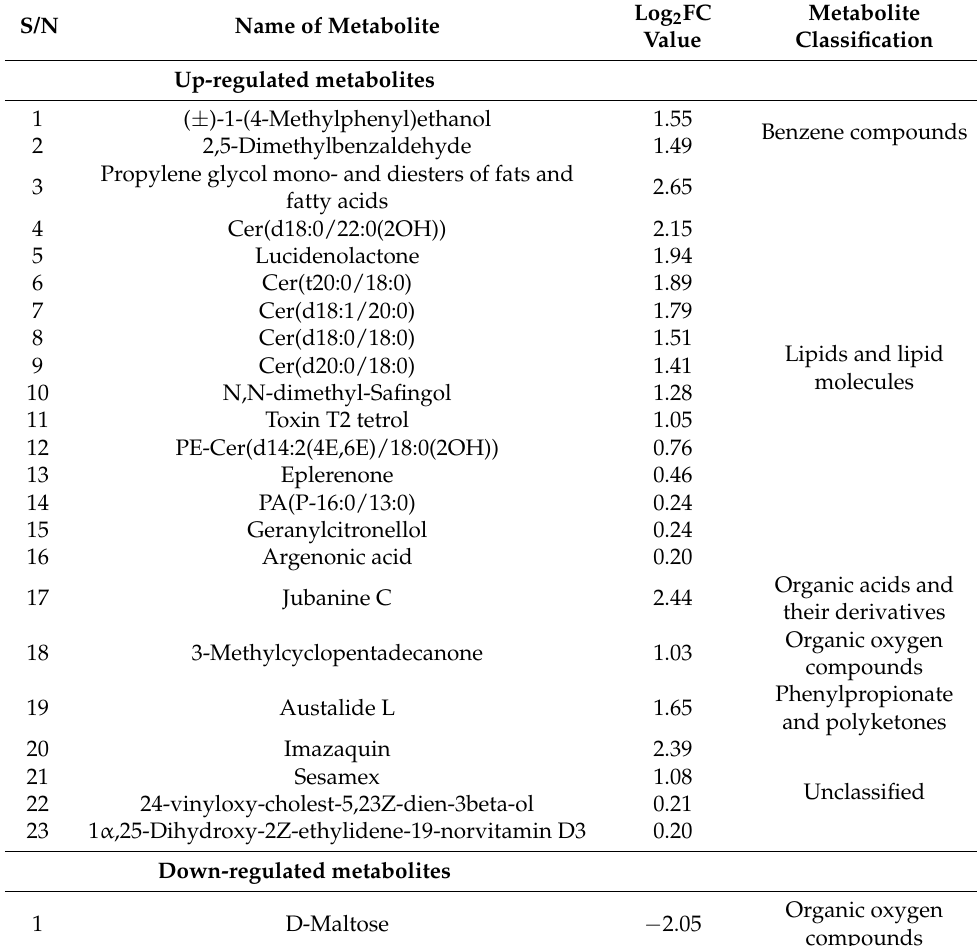
Table 3. List of differential metabolites in the 48 h 0.5 A-48 h CK